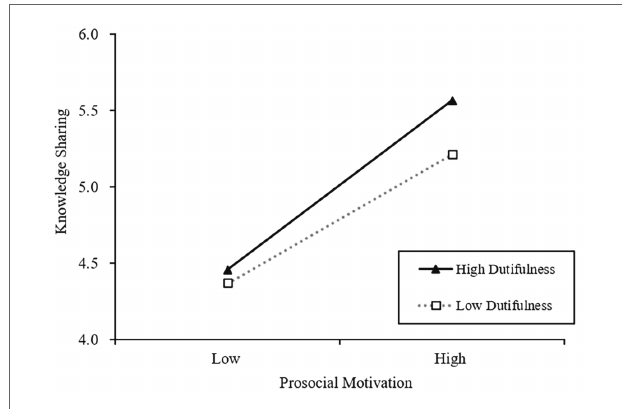
FIGURE 2 | The moderating effect of dutifulness in the relation between prosocial motivation and knowledge sharing.